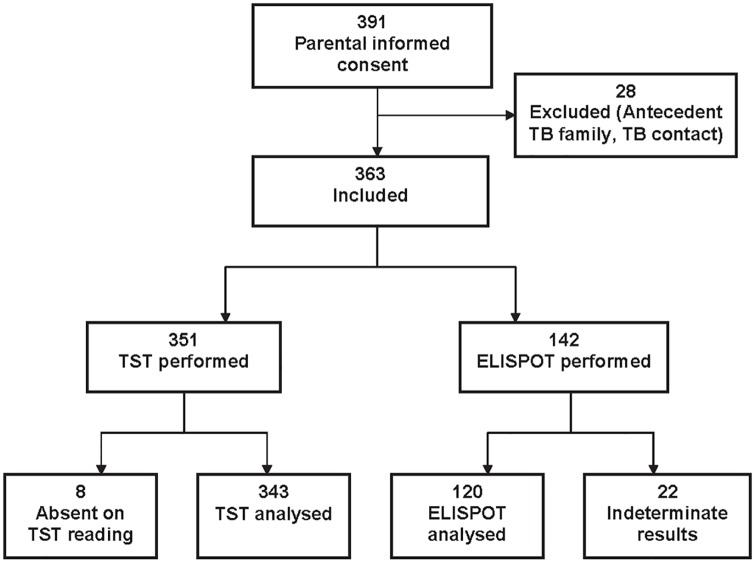
Flow chart of the study on BCG vaccine immune response in children, Antananarivo, 2010–2011.